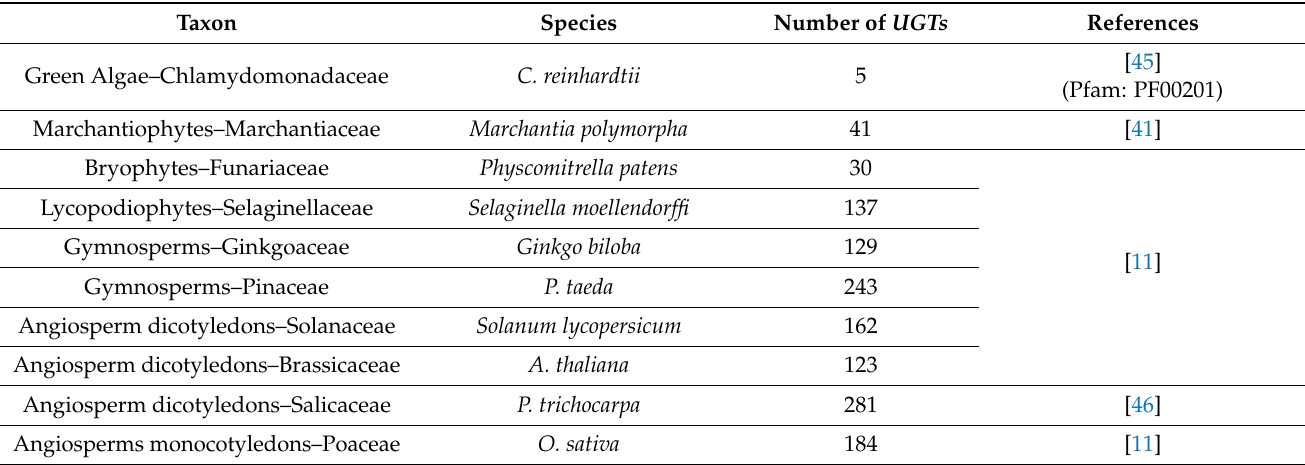
Table 1. UGTs occurrence in different species from green algae to higher